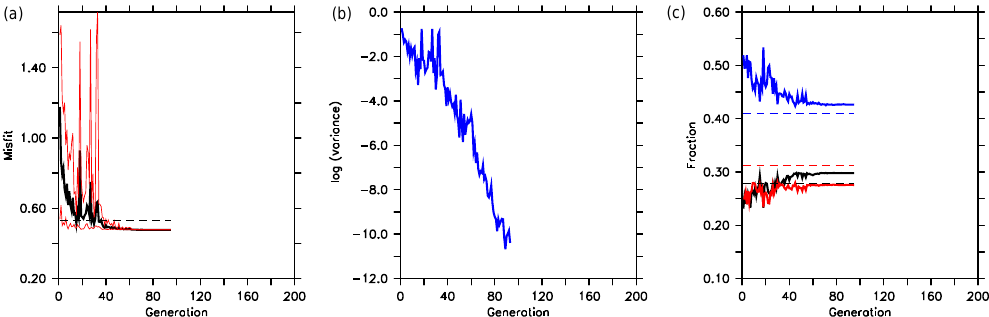
Figure 7. As Fig. 4, but for optimization OBS-WIDE. Note that in the left plot, we now show the raw value of the misfit function (not log transformed). The optimization finished at generation